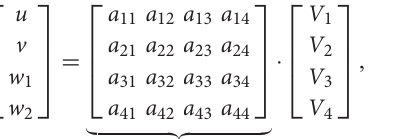
transformed into the Cartesian coordinate system ( u , v , w 1